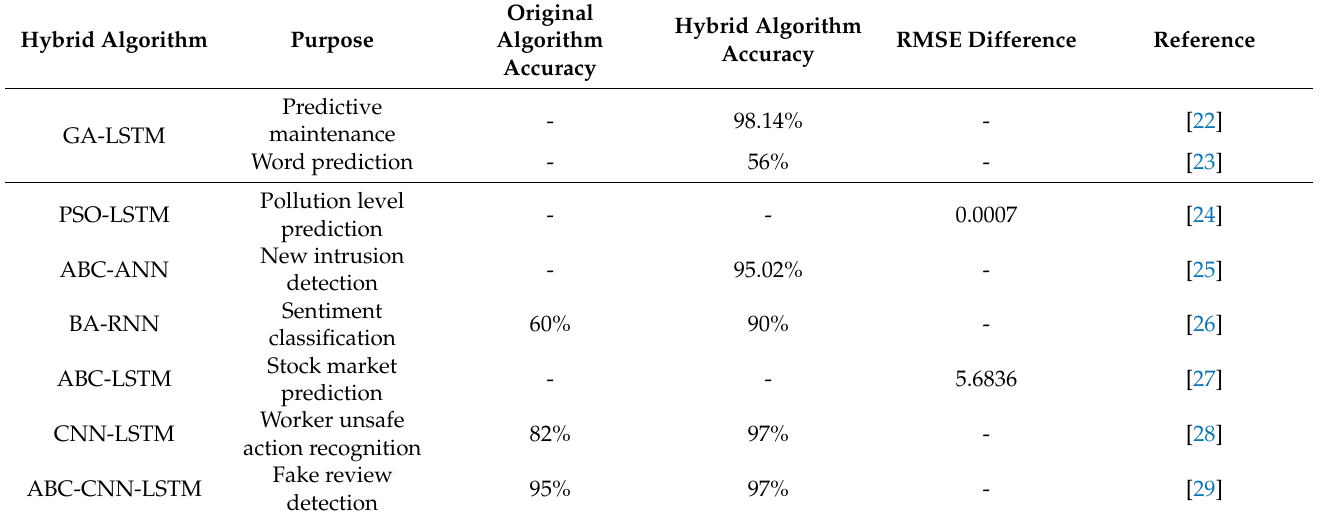
Table 1. State-of-the-art